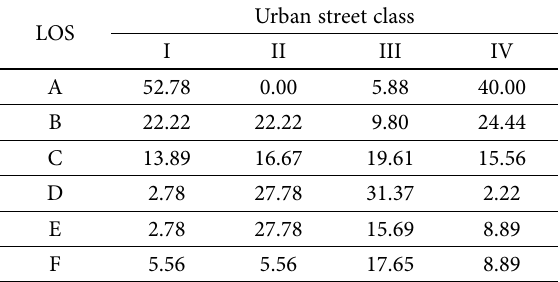
Table 4. Percentage of travel runs under levels of service categories of urban street classes in Kolkata